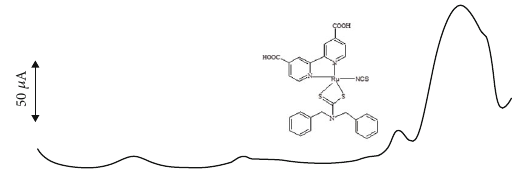
Figure 11: Square wave voltammogram of FC